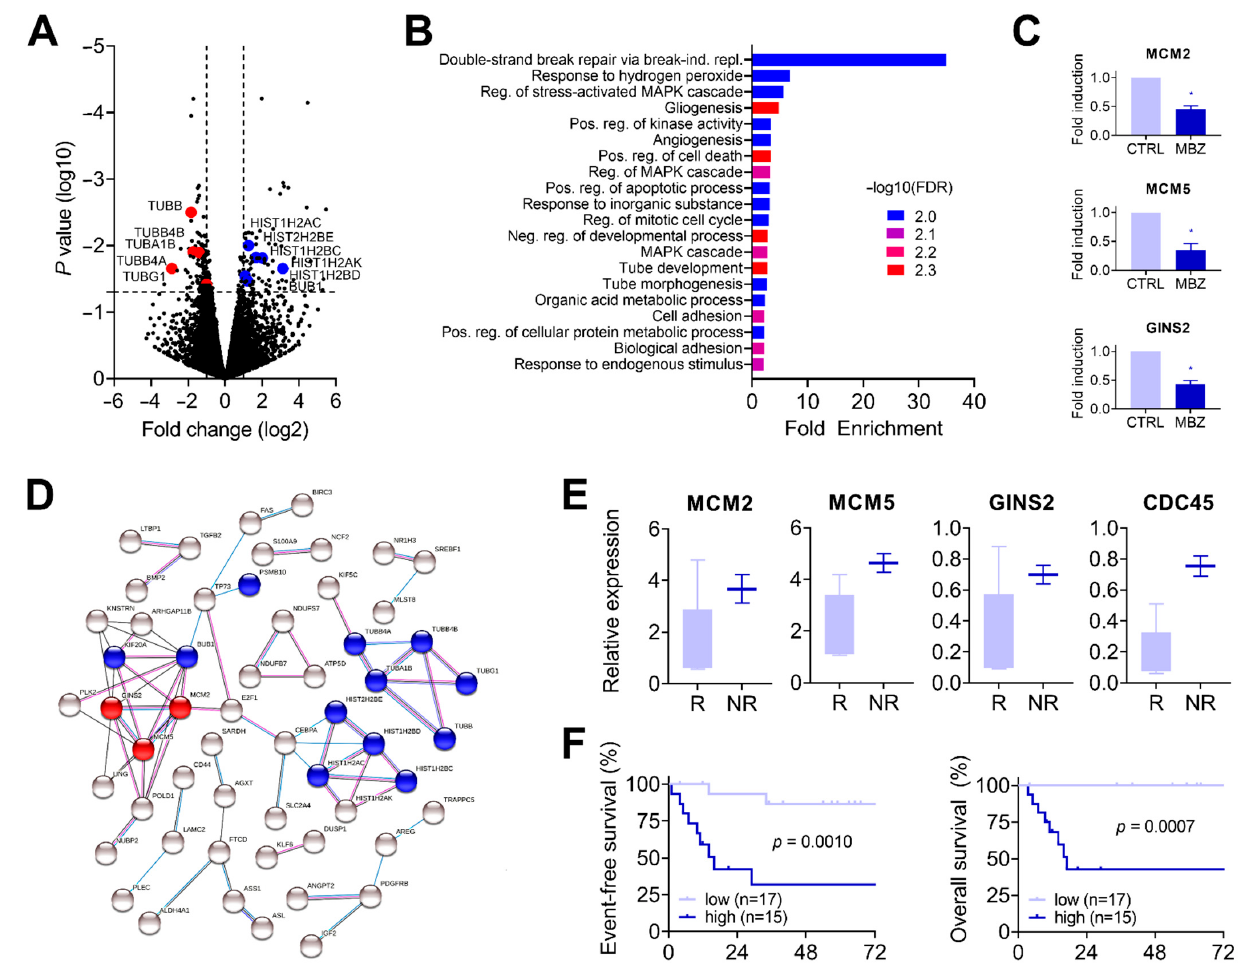
Figure 3. Mebendazole treatment alters expression of unwindosome genes. ( A ) Volcano plot of RNA expression data of HB-214, HB-282, and HB-303 cells exposed for 24 h to DMSO or mebendazole at concentrations of 2 µM, 4 µM, and 2 µM, respectively. Transcriptionally up-regulated candidate genes are depicted in blue, down-regulated genes in red. ( B ) Gene ontology analysis of differentially expressed genes with p -value < 0.05 displaying enrichment in cellular pathways. ( C ) Mean fold induction of RNA expression of the three genes contained in the top-scoring term “double-strand break repair via break-induced replication” in the DMSO (CTRL) and mebendazole (MBZ) treated tumors cell lines HB-214, HB-282, and HB-303. Error bars represent standard deviation, with * being indicative for p < 0.05 calculated from Student’s t test. ( D ) Protein-protein interaction network analysis of mebendazole regulated candidate genes. The nodes and edges represent query genes and relationships between candidates, respectively. Components of the unwindosome are highlighted in red, components of spindle/chromosome-associated cell division in blue. Blue edges indicate gene co-occurrence, black edges gene co-expression, and purple edges experimentally determined interactions. ( E ) Relative RNA expression of unwindosome genes in patient samples that responded (R) and did not respond (NR) to chemotherapy (retrieved from the Gene Expression Omnibus GSE151347 data set). ( F ) Event-free and overall survival Kaplan–Meier plots of high versus low unwindosome-expressing tumors according to the median. Expression data were retrieved from the Gene Expression Omnibus with the accession number GSE132219 [15].